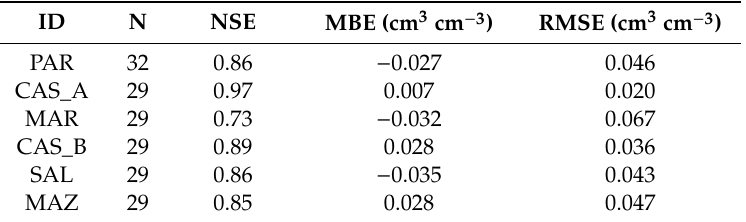
Table 4. Statistical parameters obtained by comparing estimated soil water content θ (cm 3 cm − 3 ) and the corresponding values measured in the laboratory on repacked monoliths.